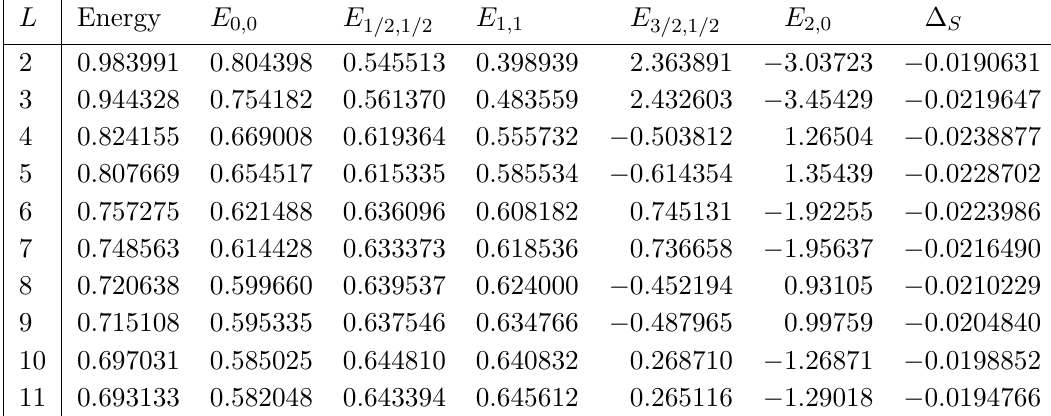
Table 8 . Selected gauge invariants of a solution probably describing 0 -brane with θ = 0 in the k = 4 model with J = 1 boundary conditions.